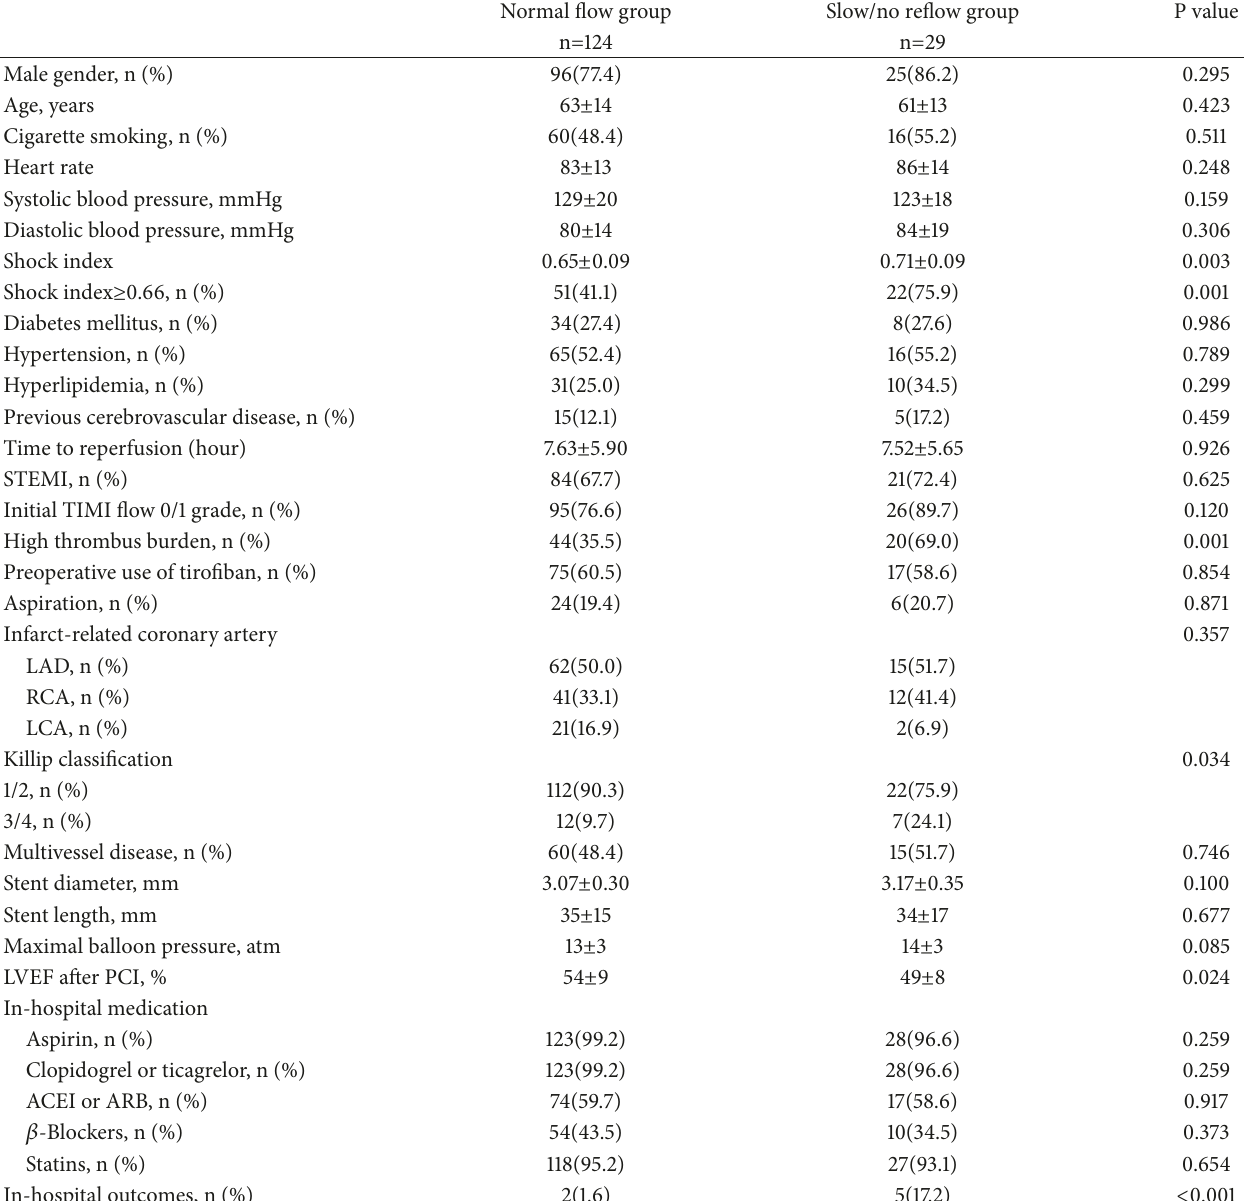
Table 1: Clinical and coronary angiographic features in patients with normal flow and slow/no